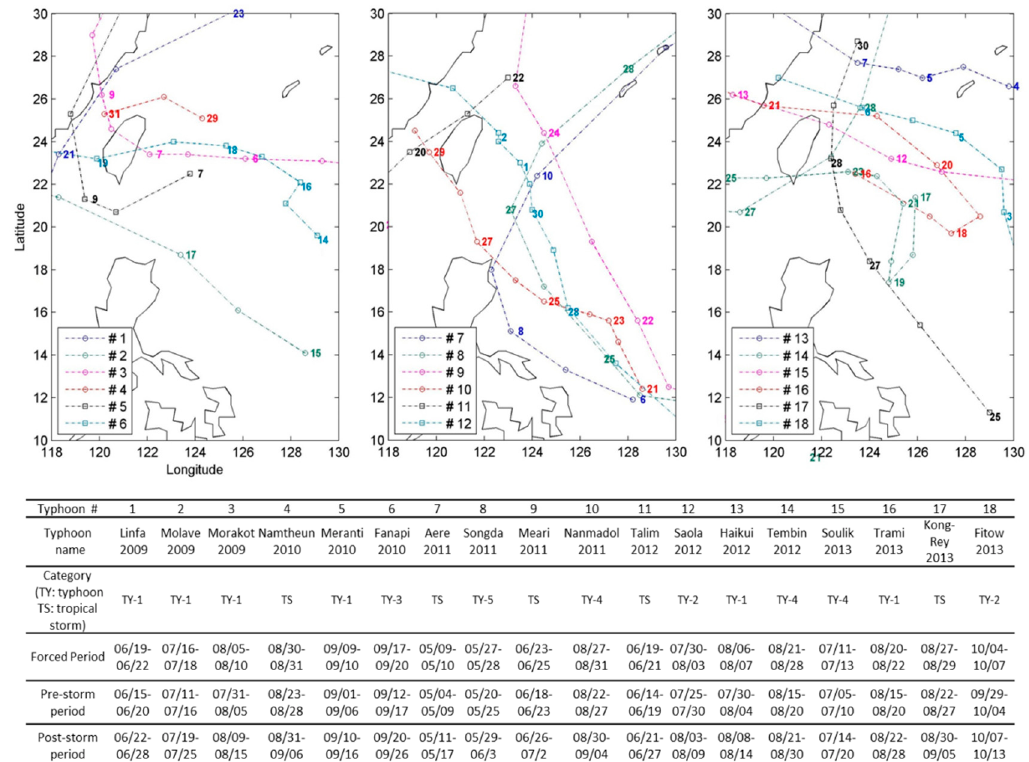
Figure 2. Tracks of the 18 typhoons that passed through the vicinity of Taiwan. The time interval between each marker is one day. The number beside each marker represents the “day.” The “month” is omitted because this is obvious from the life of the typhoon.